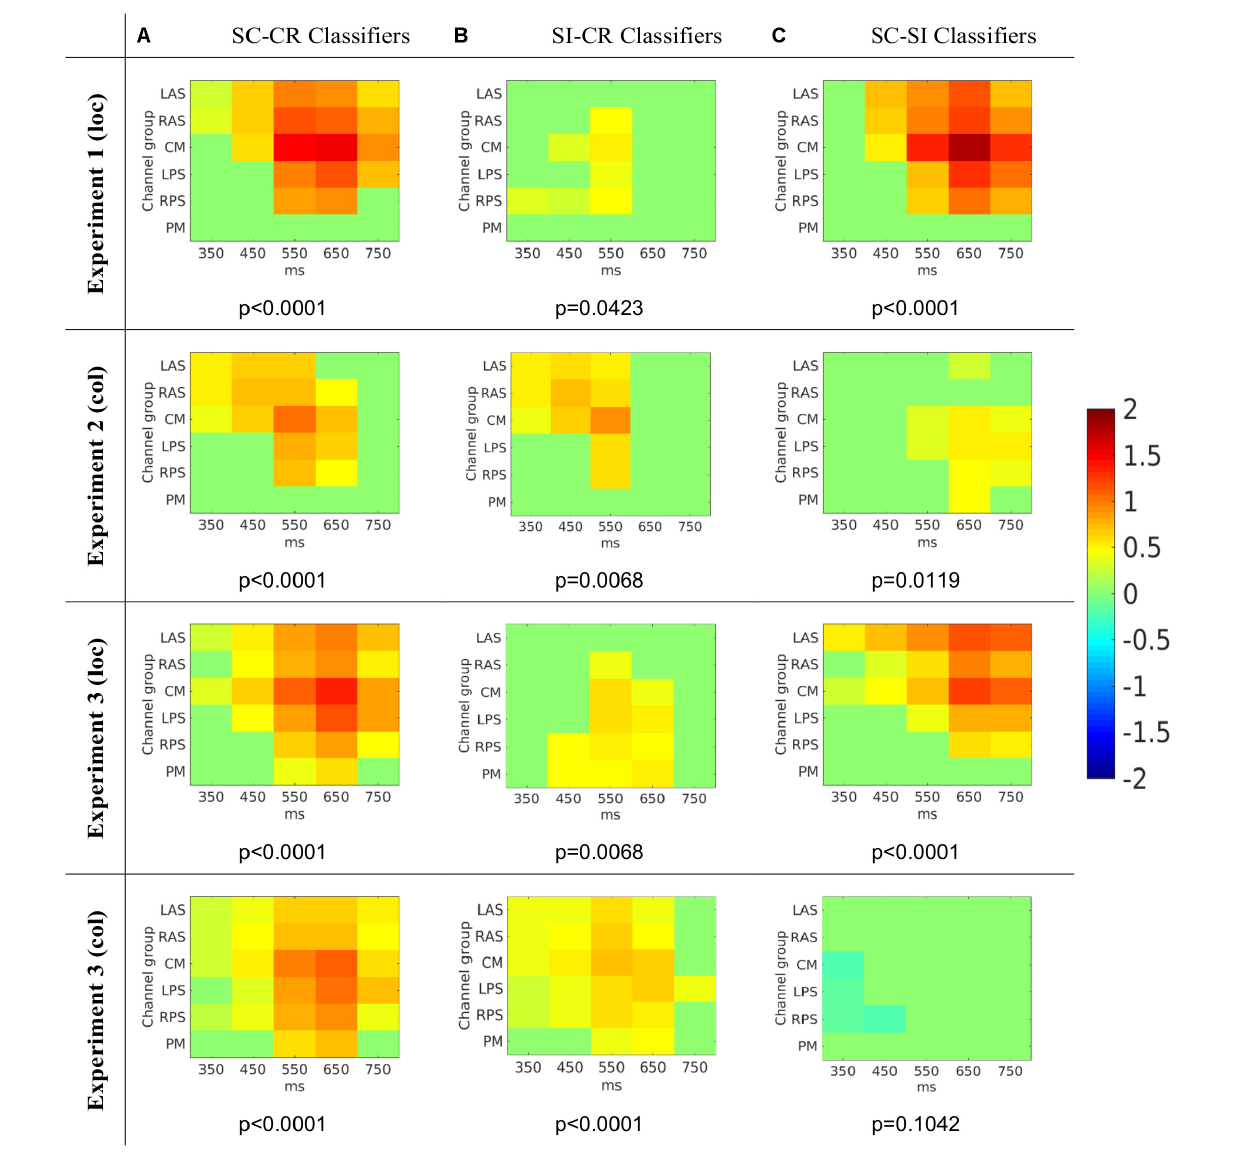
FIGURE 8 | The average activation patterns from Figure 7 but masked by the most significant cluster (with p -value for that cluster given below) (Maris and Oostenveld, 2007) for the three different classification problems ( A : SC vs. CR; B : SI vs. CR; C: SC vs. SI). Note that the numbers on the x -axes represent the mid-point of the 100 ms window used to compute the